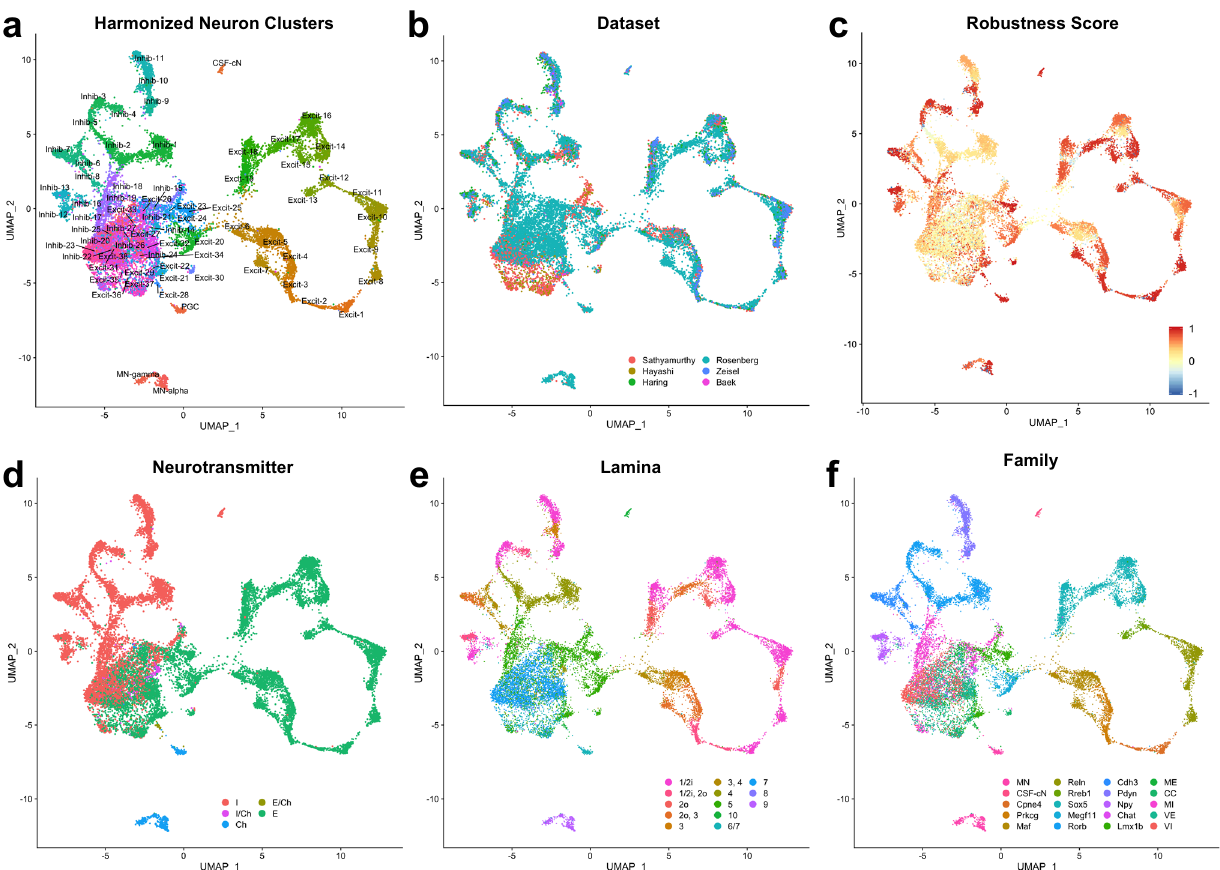
Fig. 2 Harmonized atlas of 69 populations of spinal cord neurons. a UMAP presentation of 19,353 neuronal cells/nuclei of the postnatal mouse spinal cord, colored and annotated by cell type cluster. b – f The same cells/nuclei, colored by the study of origin ( b ), by robustness (silhouette) score ( c ), a neurotransmitter ( d ), lamina ( e ), and family ( f ). I inhibitory, I/Ch inhibitory cholinergic, Ch cholinergic, E/Ch excitatory cholinergic, E excitatory, MN motoneurons, ME mid excitatory, CC Clarke ’ s Column (*see main text for note on this designation), MI mid inhibitory, VE ventral excitatory, VI ventral inhibitory. Laminae were assigned based on in situ hybridization validation experiments and are colored by the approximate depth from the dorsal surface of the cord (hot pink to violet). See main text for description of neuronal